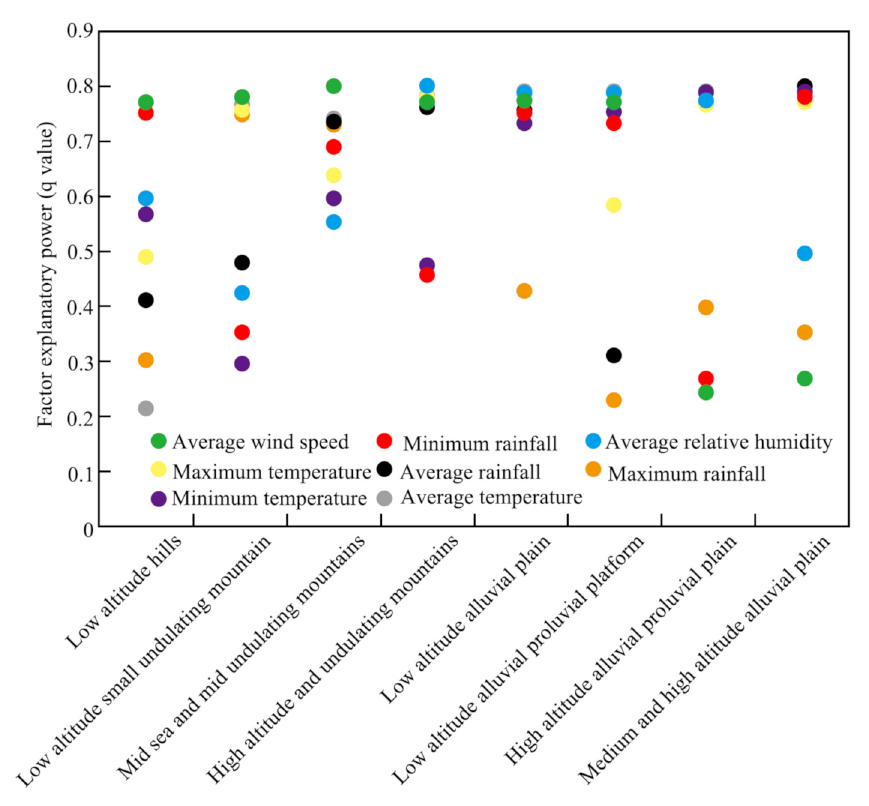
Figure 10. Influence of meteorological factors on cultivated land differentiation in different geomor- phic